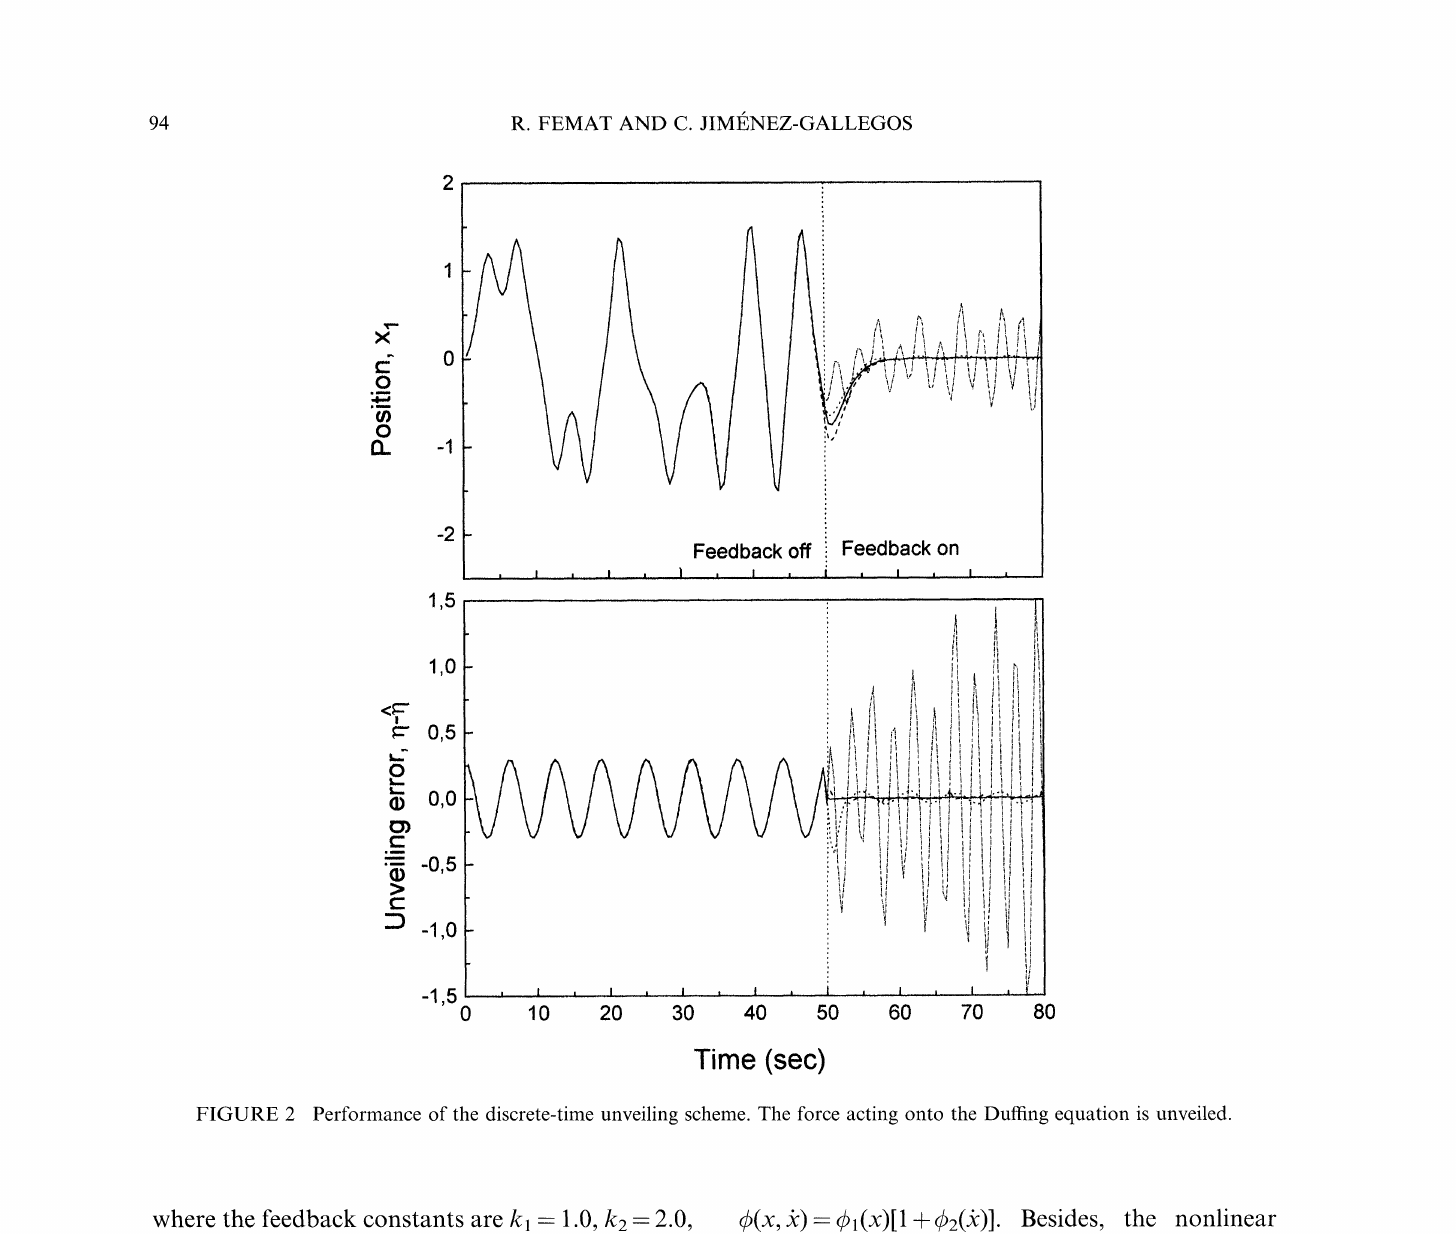
where the feedback constants are kl 1.0, k2--